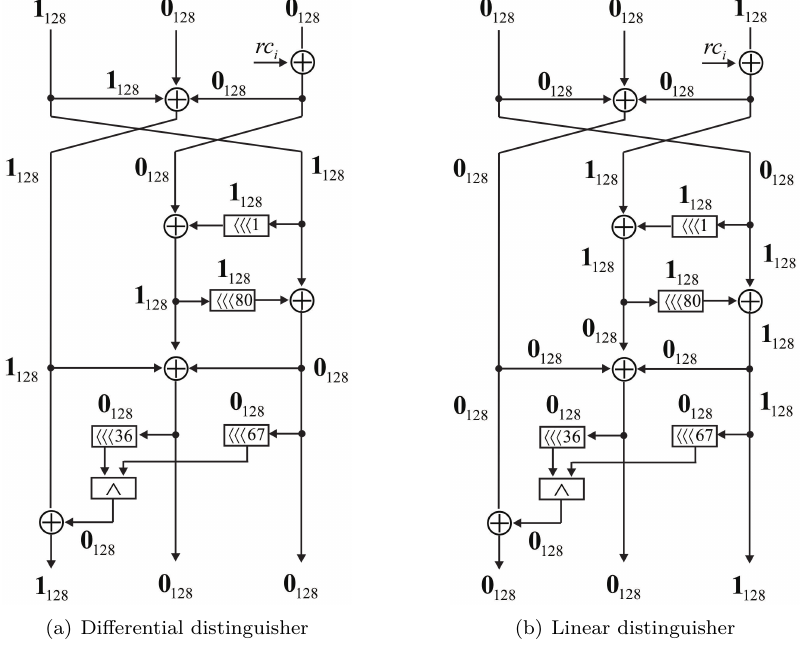
Figure 2: The differential and linear distinguishers of 1-round